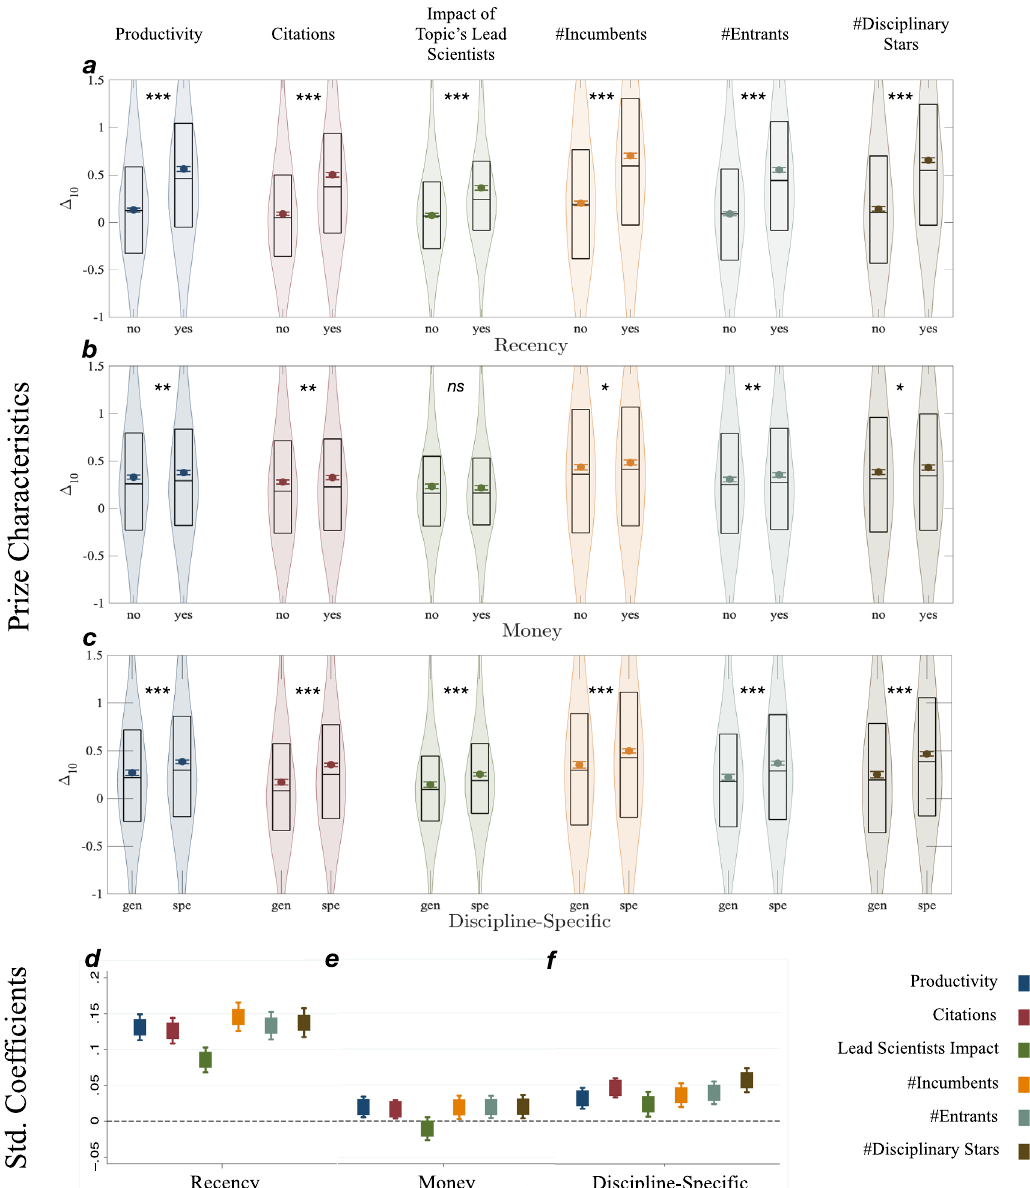
Fig. 4 Prize characteristics predict the magnitude of extraordinary growth. a through c show the raw data relationship between a prize ’ s characteristics and the estimated magnitude of Δ 10 on 6 growth measures (*** p < 0.001; ** p < 0.01; and * p < 0.05). The color dots with error bars represent the mean value and 95% CI, the center line of the black box plot is the median, box limits correspond to the data ’ s fi rst and third quartiles, and violin shades represent the data ’ s distribution. Two-sided t -test are used in these analyses. The p -value for a ranges from 2 : 70 ´ 10 (cid:2) 180 to 5 : 30 ´ 10 (cid:2) 67 , for c ranges from 1 : 60 ´ 10 (cid:2) 25 to 9 : 06 ´ 10 (cid:2) 9 , and for b p -value ranges from 0.0017 to 0.013 except for lead scientist impact ( p -value = 0.374). Sample sizes for topics associated with prizes with recency, money, and discipline speci fi c are n = 5672 (46.73%), n = 6102 (50.27%), and n = 8812 (72.59%) respectively. d – f show the standardized coef fi cient from a regression of Δ 10 on all three prize characteristics, indicating the signi fi cant and substantive association between prize characteristics and the magnitude of the expected level of extraordinary growth in a topic after it is associated with a prize. Con t rol variables are lagged Δ t at t = − 1, − 2, − 3, discipline, year, prize visibility and reputation, and prizewinner status. Error bars demonstrate 95% CI. Please see Supplementary Tables S2 – S10 for details of regression analyses and further robustness